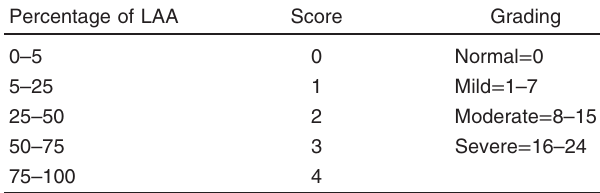
Table 2 The method of Goddard score calculation Percentage of LAA